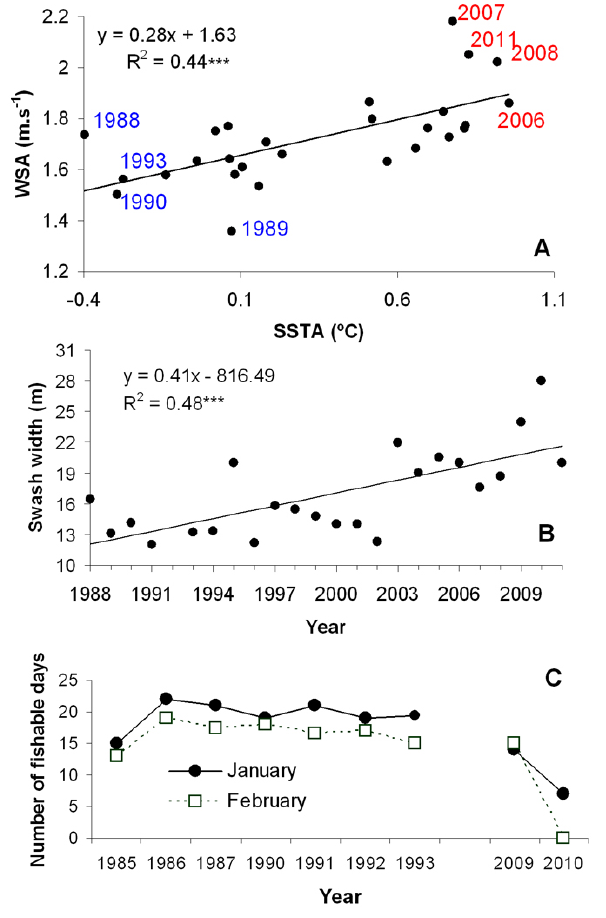
Fig. 2 . (A) Long-term variations in sea surface temperature anomalies and wind speed anomalies for the southwestern Atlantic Ocean. Values corresponding to the beginning and end of the time series are highlighted. (B) Long-term linear increase in the swash width at Barra del Chuy beach, Uruguay, where the yellow clam ( Mesodesma mactroides ) is harvested. (C) Variations in the number of fishable days for January and February (austral summer), which constitute the months with the highest fishing activity. *** P < 0.001. A and B: data source from Ortega et al. (2013). C: original